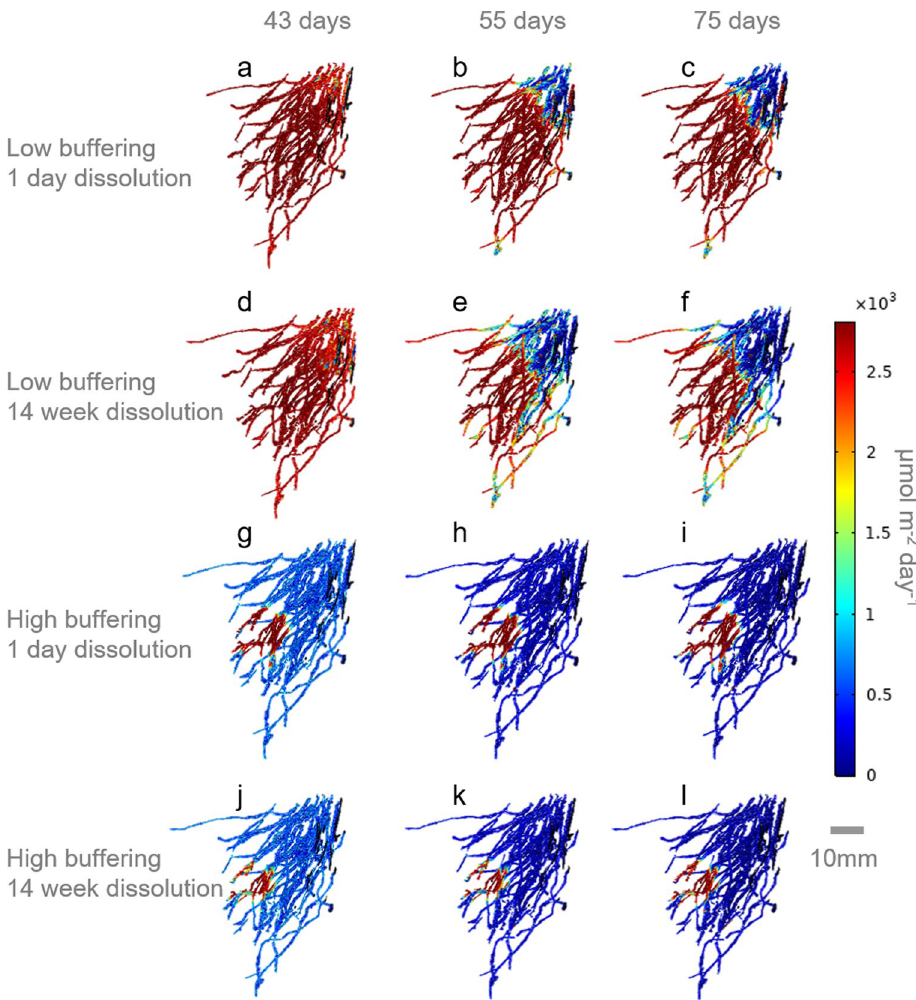
Figure 3. Visualisation of the root uptake rate evolution of the sample 01 root system for the 1-day and 14-week dissolution treatments. Pellet dissolution began at Day 0, root P uptake was switched on at Day 42. Day 43, 55 and 75 are selected for visualisation purposes. ( a – c ) Show the low buffering soil with 1-day fertiliser dissolution. ( d – f ) Show the low buffering soil with 14-week fertiliser dissolution. ( g – i ) Show the high buffering soil with 1-day fertiliser dissolution. ( j – l ) Show the high buffering soil with 14-week fertiliser